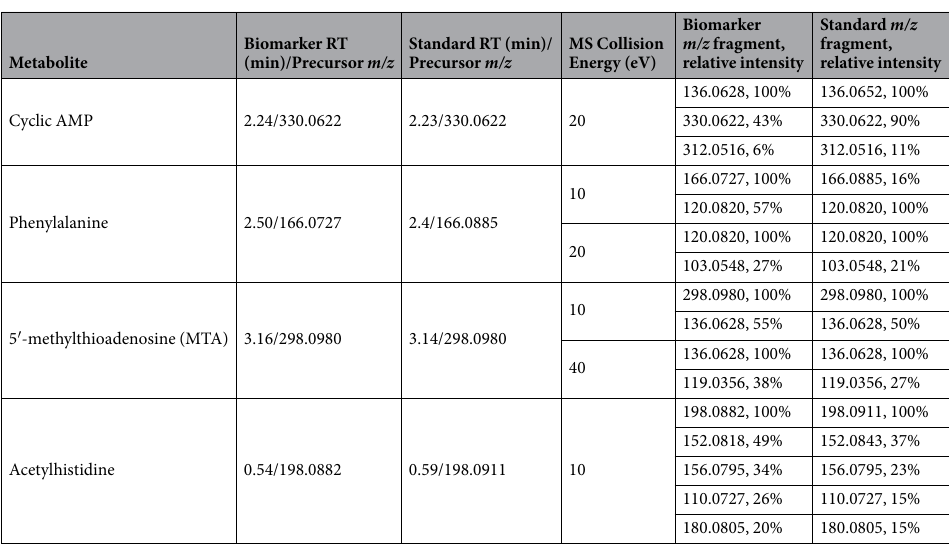
Table 2. Comparison of retention time, precursor m/z , fragments m/z , and fragments relative intensity between biomarkers and